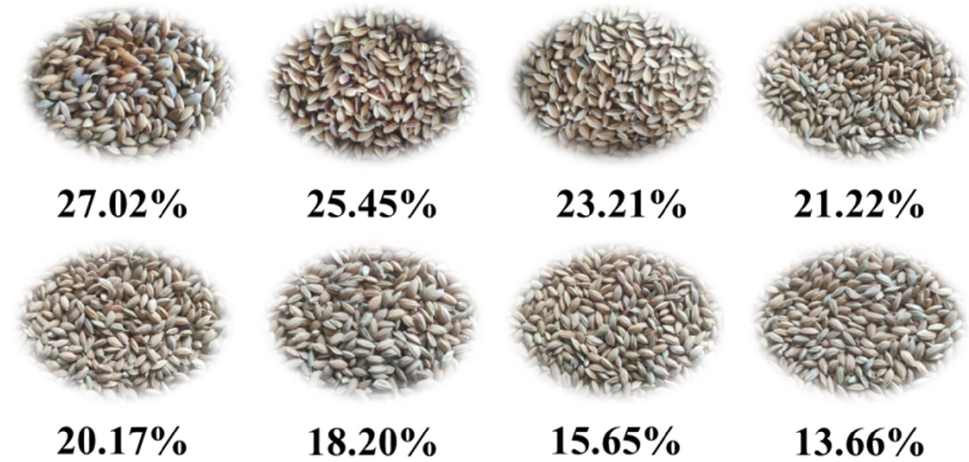
Figure 7. Paddy rice samples with different moisture contents.